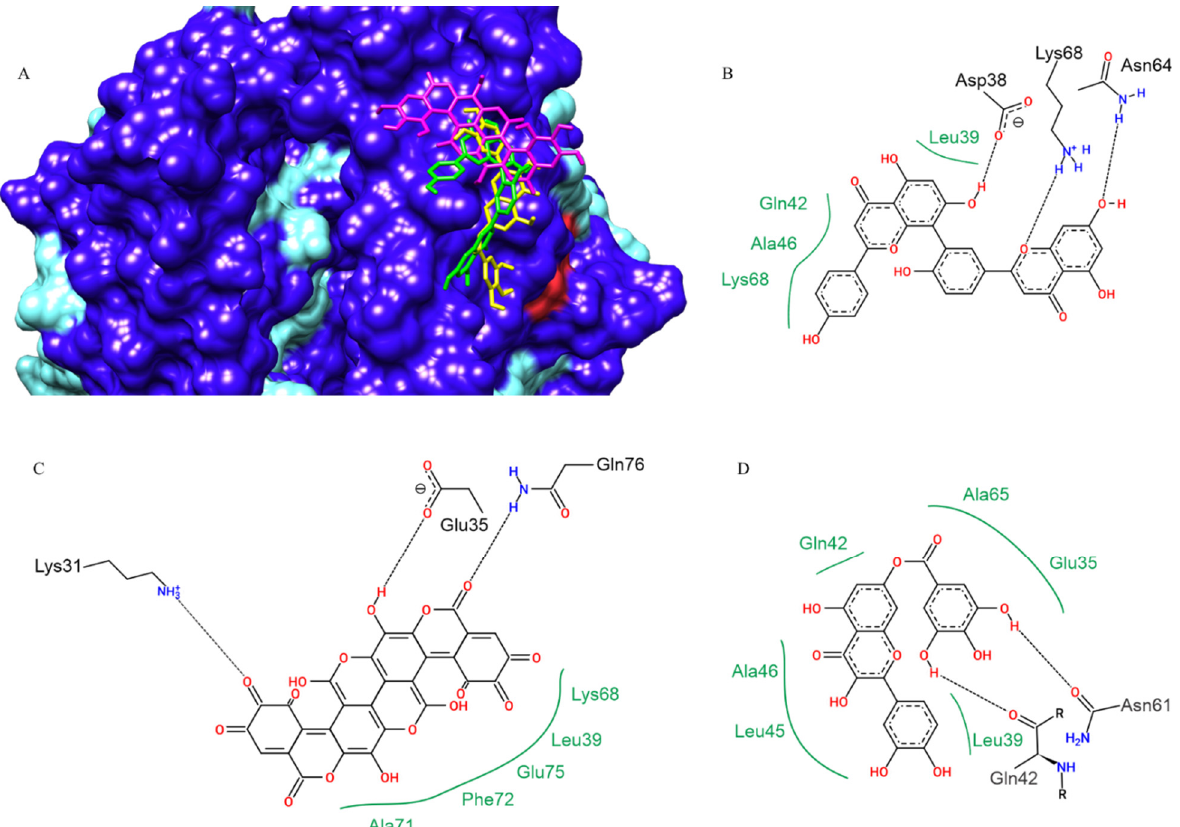
Figure 7. Amentoflavone (green), 7-O-galloylquercetin (yellow), and gallagic acid (magenta) docking positions on human ACE-2 (SARS-CoV-2 RBD spike protein binding site), in surface view ( A ). Contacts of SARS-CoV-2 Spike protein active site residues with amentoflavone ( B ), gallagic acid ( C ), and kaempferitrin ( D ) are depicted in a two-dimensional diagram. Dashed black lines indicate hydrogen bonds; full green lines indicate van der Waals interactions.